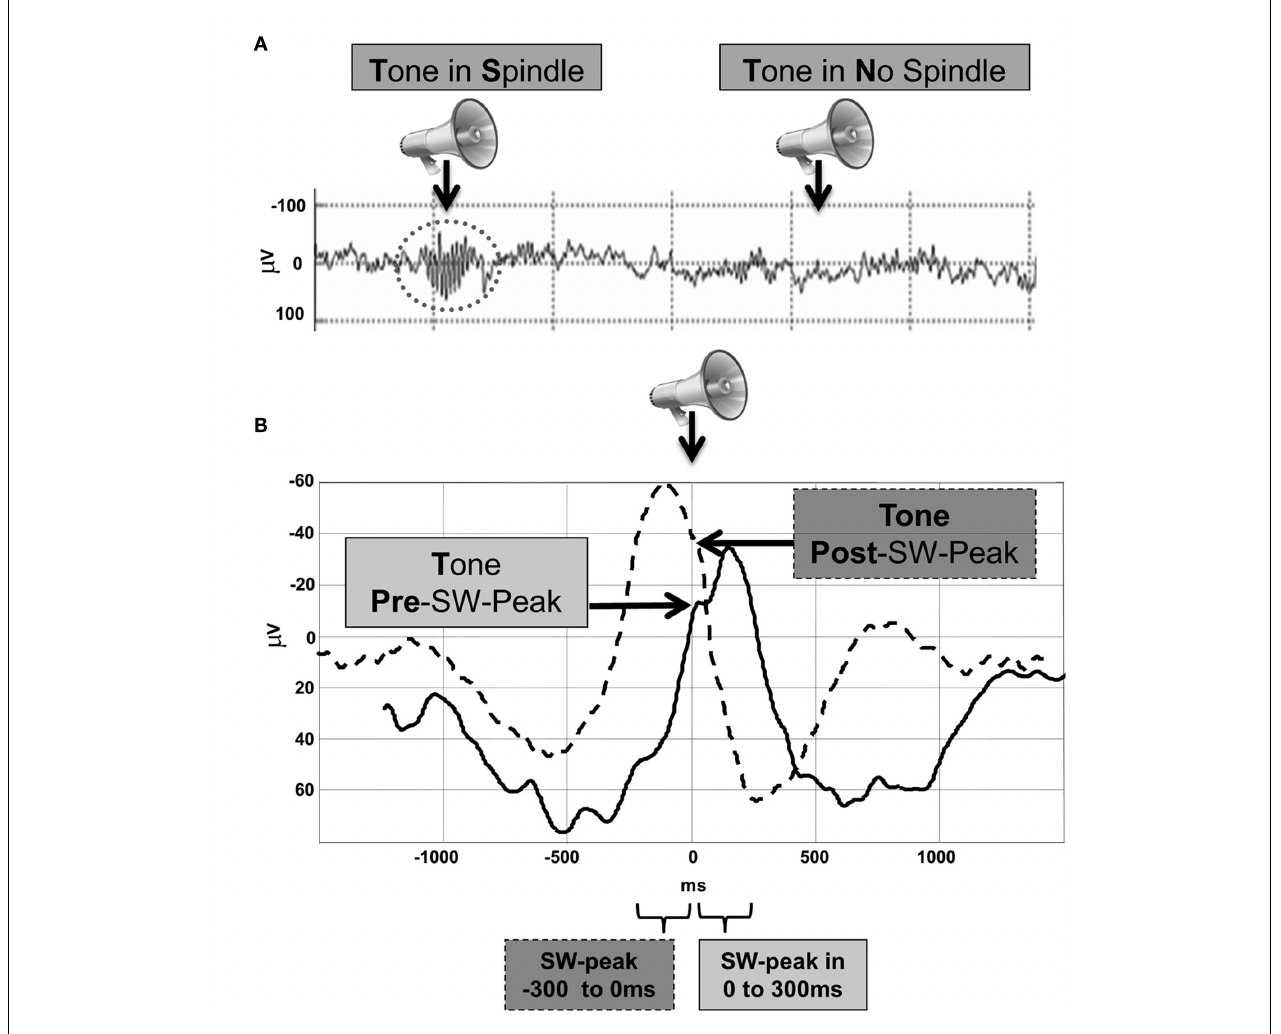
randomly presented (at 70% of everyTR) and post hoc categorized according to (i) the absence or presence of spindles (stage 2–3) or (ii) the phase of the slow oscillation (stage 3–4) when the tone